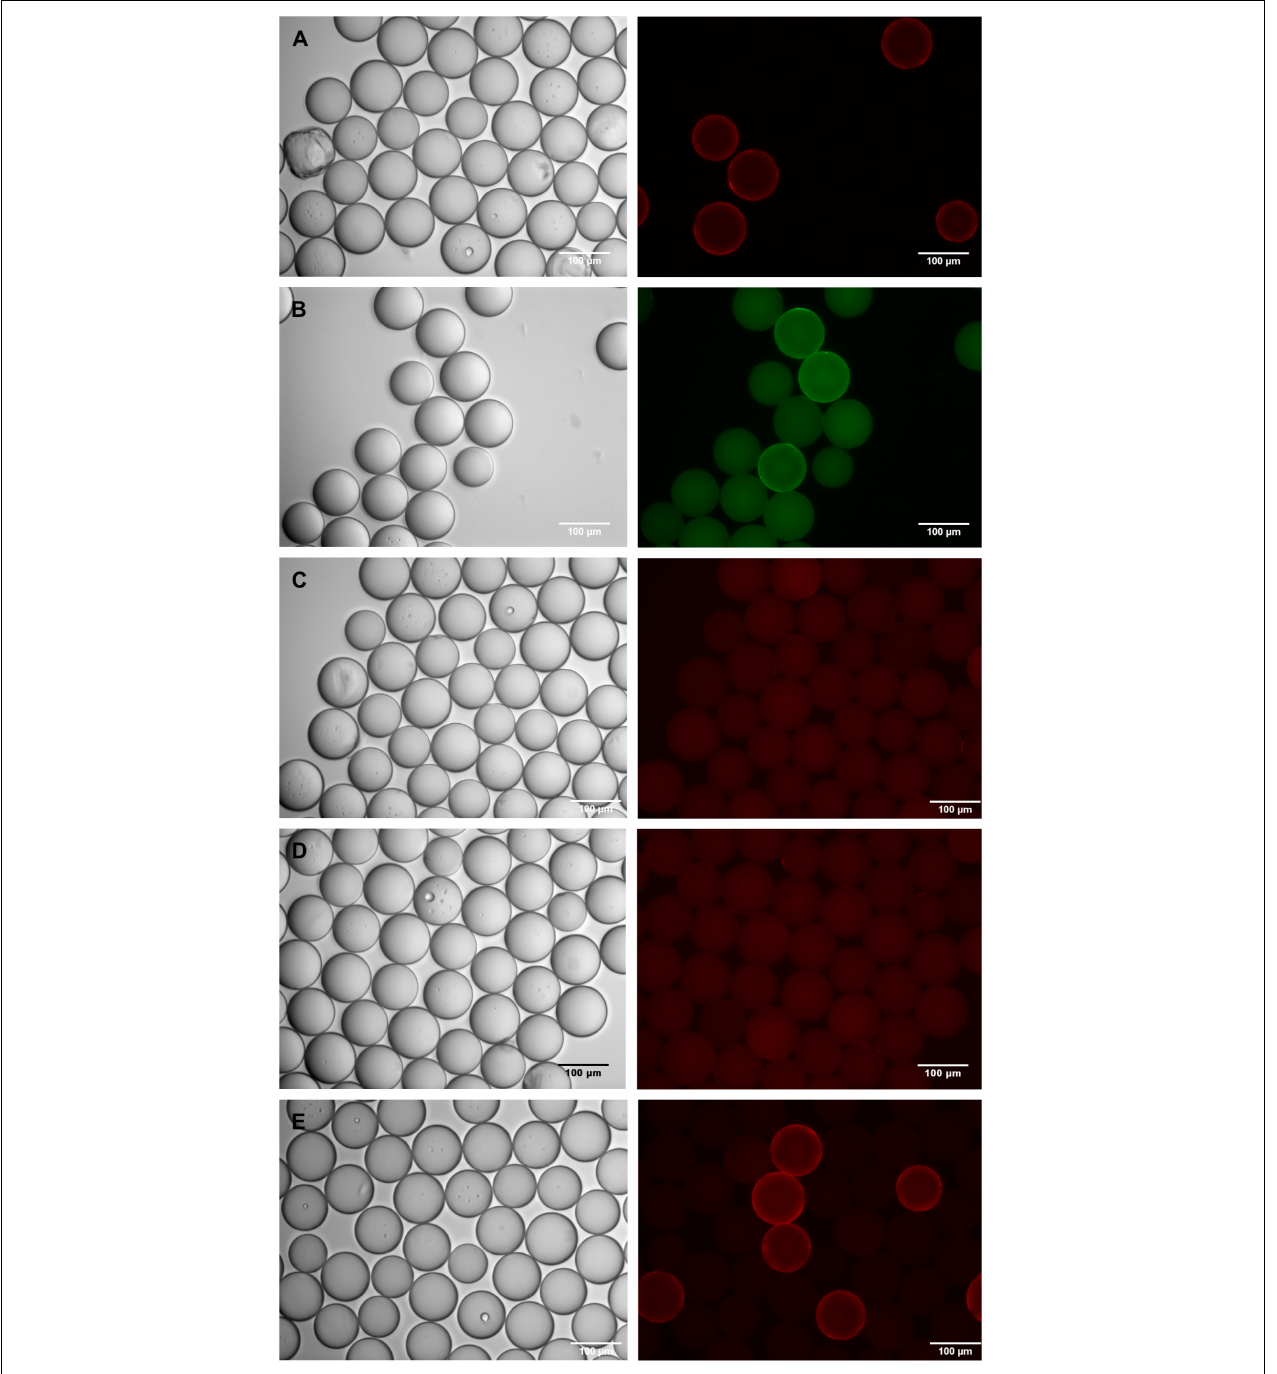
FIGURE 3 | Detection of Ara h 2-beads, diluted 1:10, in an artificial peptide library of scrambled Ara h 2 beads. Beads were incubated with serum from two different peanut-allergic patients, and IgE-binding was detected with fluorophore-labeled anti-IgE antibodies. Phase contrast images are shown on the left, corresponding fluorescence images of the appropriate channel on the right side of the panel. (A) Beads incubated with serum from patient 1, diluted to approximately 90 ng Ara h 2-specific IgE/ml; IgE-binding detected with phycoerythrin-labeled monoclonal anti-IgE antibody; (B) Beads incubated with serum from patient 1, diluted to approximately 23 ng Ara h 2-specific IgE/ml; IgE-binding detected with DyLight488-labeled polyclonal anti-IgE antibody; (C) Beads incubated with total serum from patient 2, diluted to approximately 33 ng Ara h 2-specific IgE/ml; IgE-binding detected with phycoerythrin-labeled monoclonal anti-IgE antibody; (D) Beads incubated only with phycoerythrin-labeled monoclonal anti-IgE antibody; (E) Beads incubated with IgG-depleted serum from patient 2, diluted to approximately 33 ng Ara h 2-specific IgE/ml; IgE-binding detected with phycoerythrin-labeled monoclonal anti-IgE antibody. Quantitation of fluorescence intensities can be found in the Supplementary Figure 3